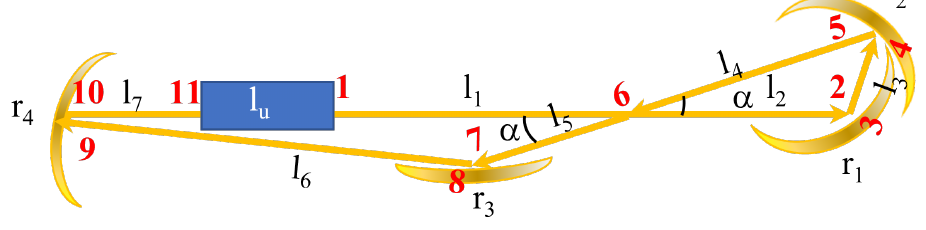
Figure 10. Dual source of THz and X-ray radiation. The cavity is constituted by four mirrors, one of them ( r 1 ) holed for THz and X-ray extraction. Point 1: undulator exit. Point 2: arrival on mirror 1. Point 3: departure from mirror 1. Point 4: arrival on mirror 2. Point 5: departure from mirror 2. Point 6: interaction point. Point 7: arrival on mirror 3. Point 8: departure from mirror 3. Point 9: arrival on mirror 4. Point 10: departure from mirror 4. Point 11: undulator entrance. Electron beam and THz radiation interact at an angle α of few